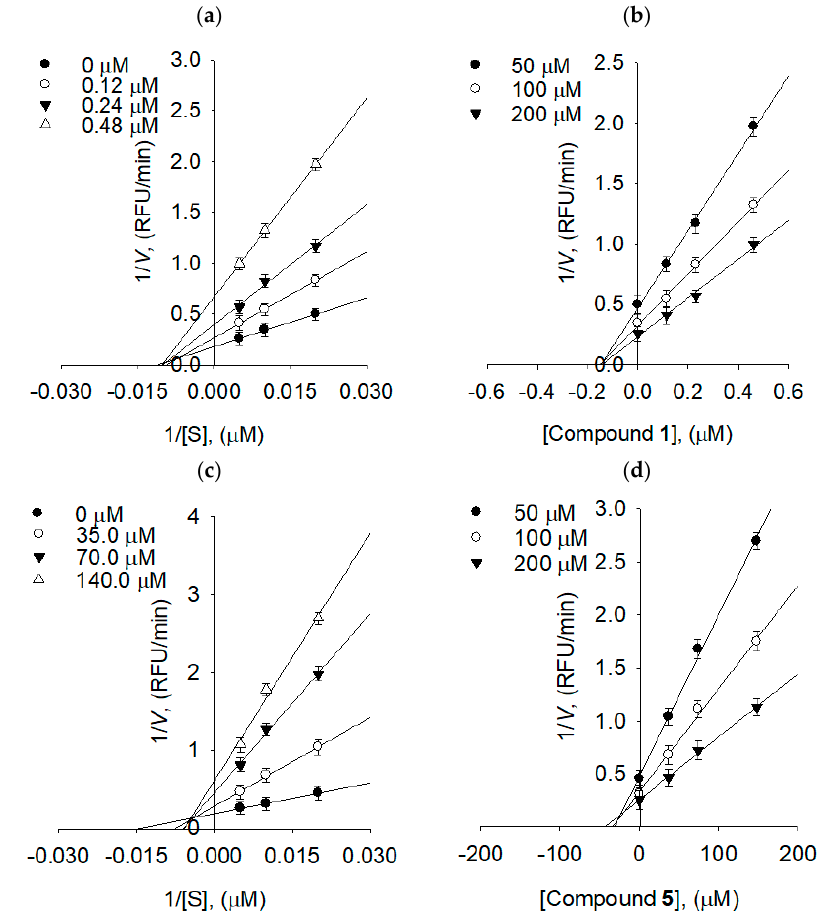
Figure 5. Bacterial neuraminidase kinetics of compounds 1 and 5 using 4-methylumbeliferyl- α - D - N -acetylneuraminic acid sodium salt hydrate. ( a ) Lineweaver–Burk plots of compound 1 , ( b )